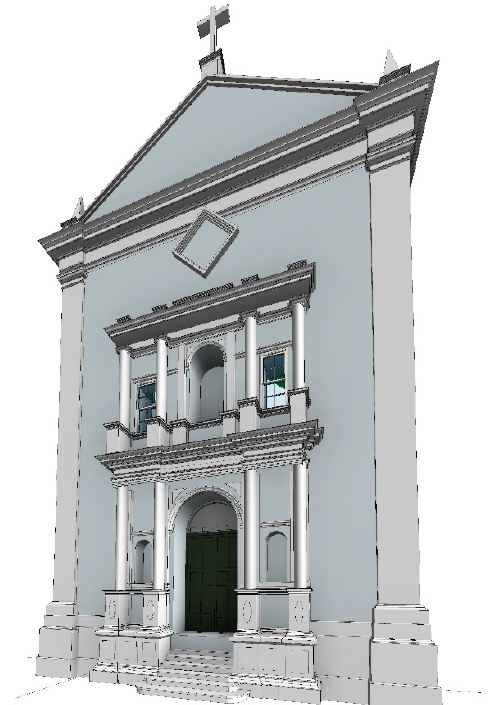
Figure 5. BIM model.